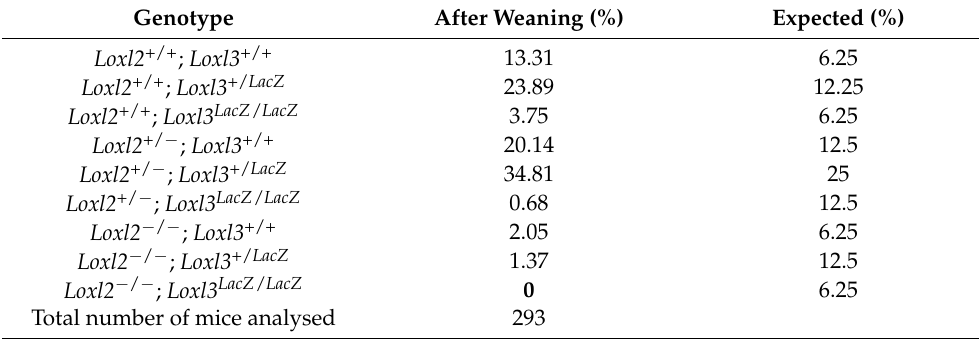
Table 2. Genotype frequency of the offspring from Loxl2 +/ − ; Loxl3 +/ LacZ crossings. Value reflecting the postnatal lethality associated with double Loxl2 / Loxl3 KO is indicated in bold. Genotype